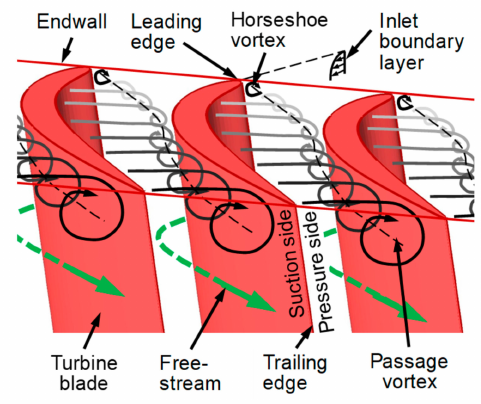
Figure 1. Passage vortex generated among turbine